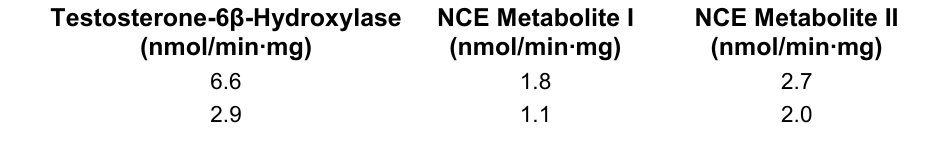
Specific Antibodies